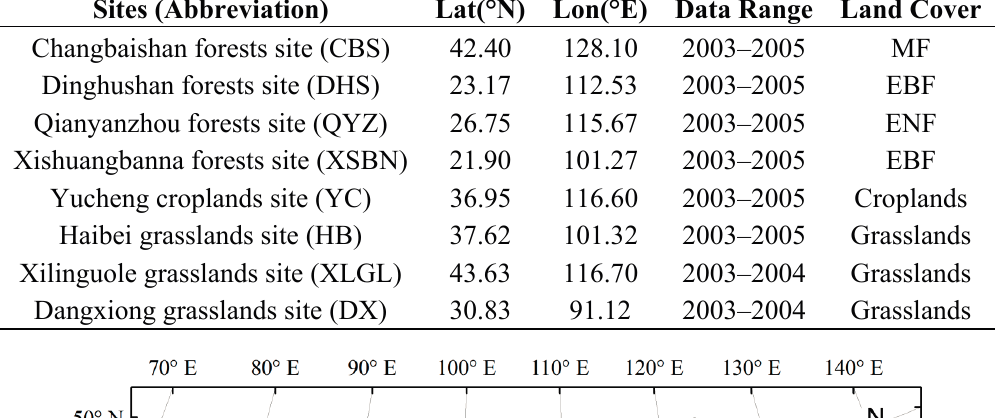
broadleaf forests; ENF: Evergreen needleleaf forests.